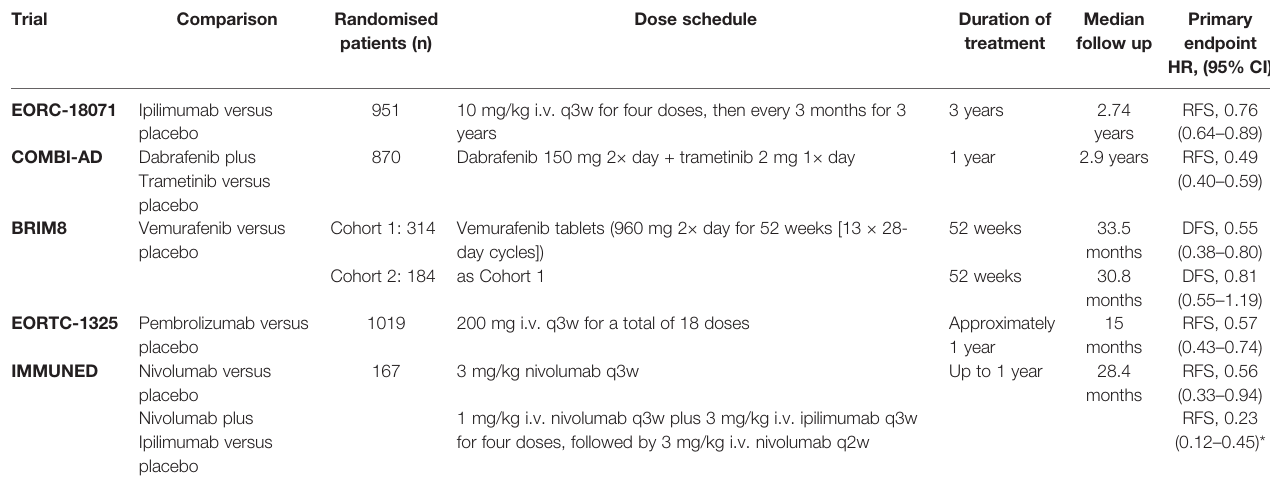
Dose schedule Duration of